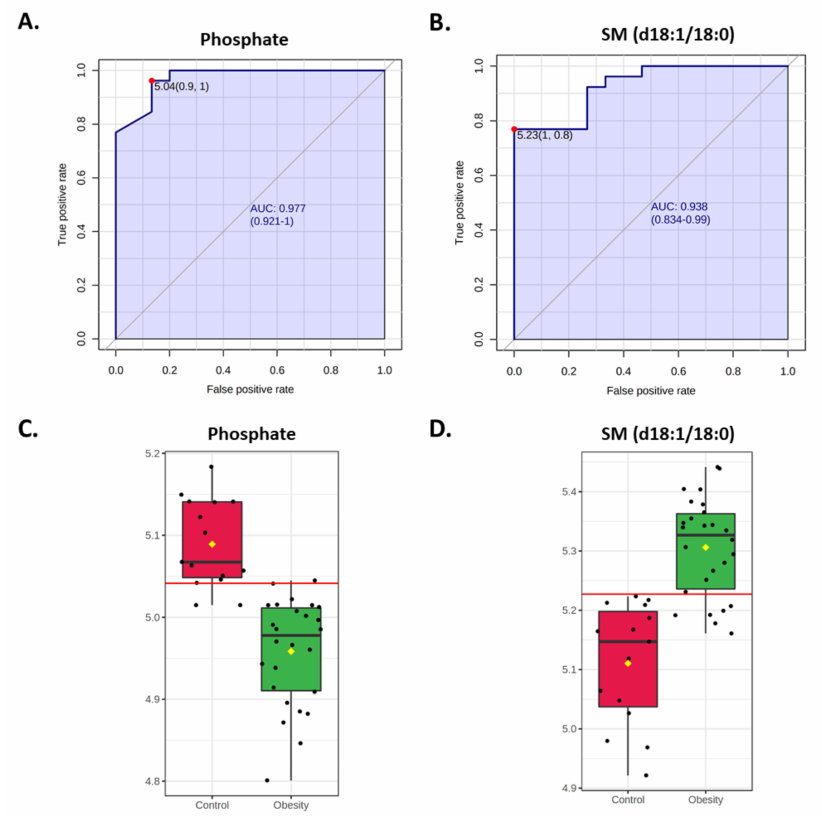
Figure 5. Univariate ROC curve results for phosphate and sphingomyelin SM (d18:1/18:0). ( A , B ) ROC curves for ( A ) phosphate ( A ) and ( B ) SM (d18:1/18:0). Sensitivity and specificity are shown on the y- and x-axes, respectively. The area-under-the-curve (AUC) is in blue, and 95% CIs are shown. ( C , D ) Box-plots of ( C ) phosphate and ( D ) SM (d18:1/18:0) between children with (green) and without (red) obesity. The red horizontal line represents the optimal cut-off.